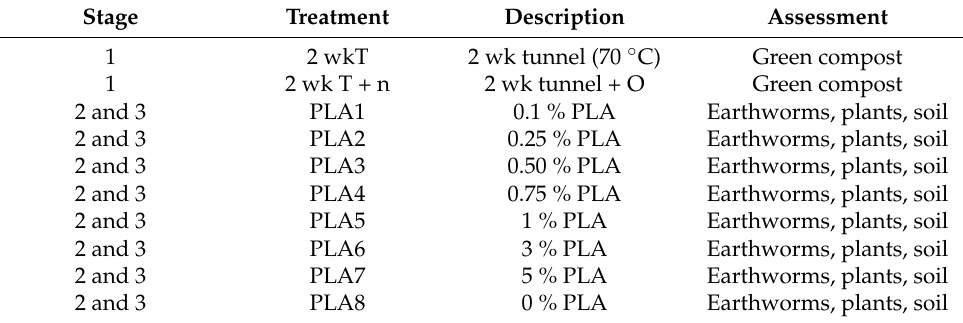
Table 1. Experimental design and treatment